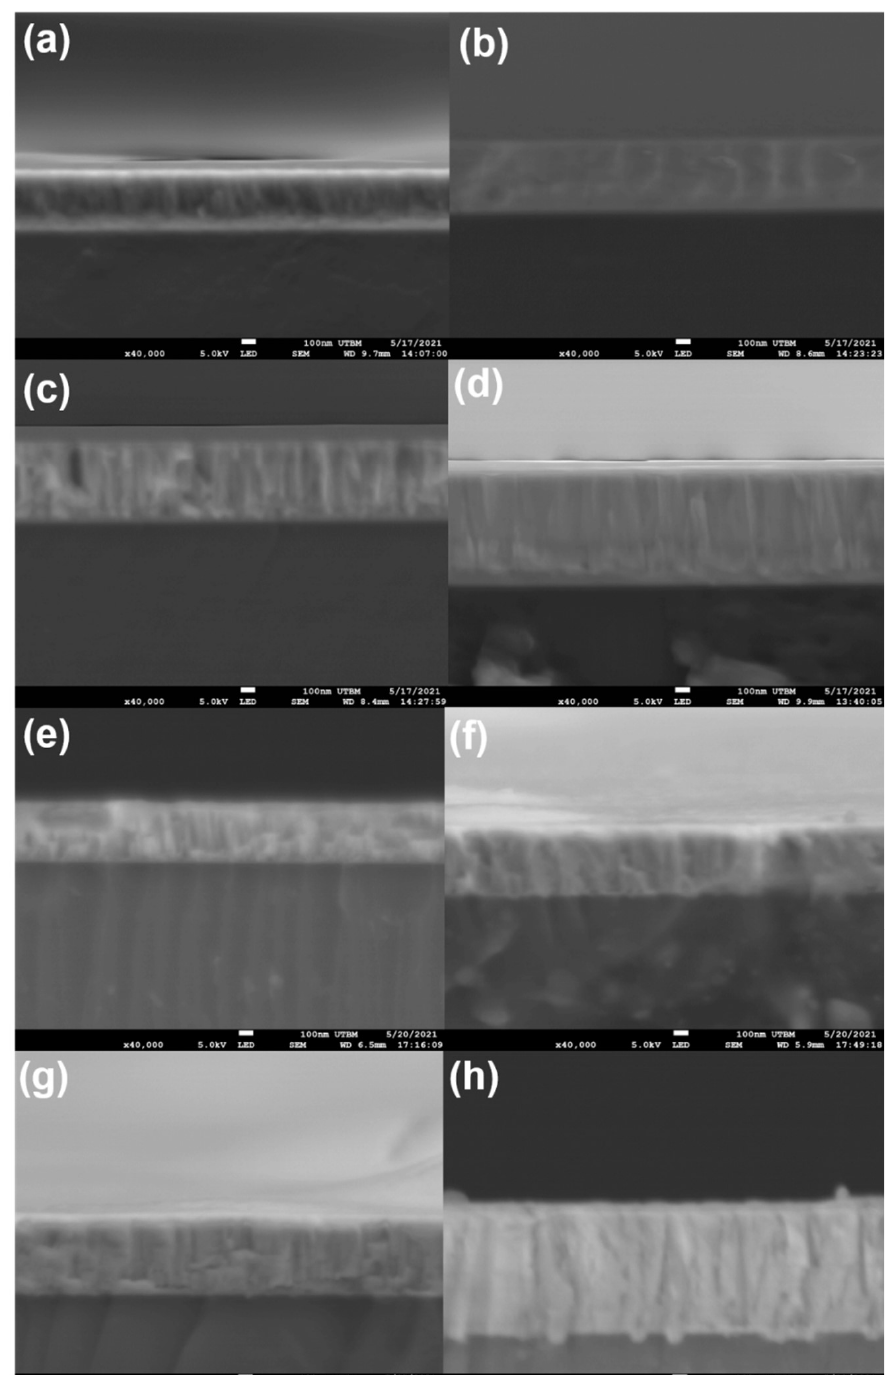
Figure 4. FESEM characterization of the brittle fracture cross-section of the films deposited on silicon wafer with different atomic ratios of as deposited ( a ) Bi/Y = 2.2, ( b ) Bi/Y = 3.1, ( c ) Bi/Y = 4.9, ( d ) Bi/Y = 6.9 and annealed at 500 °C ( e ) Bi/Y = 2.2, ( f ) Bi/Y = 3.1, ( g ) Bi/Y = 4.9, ( h ) Bi/Y = 6.9.